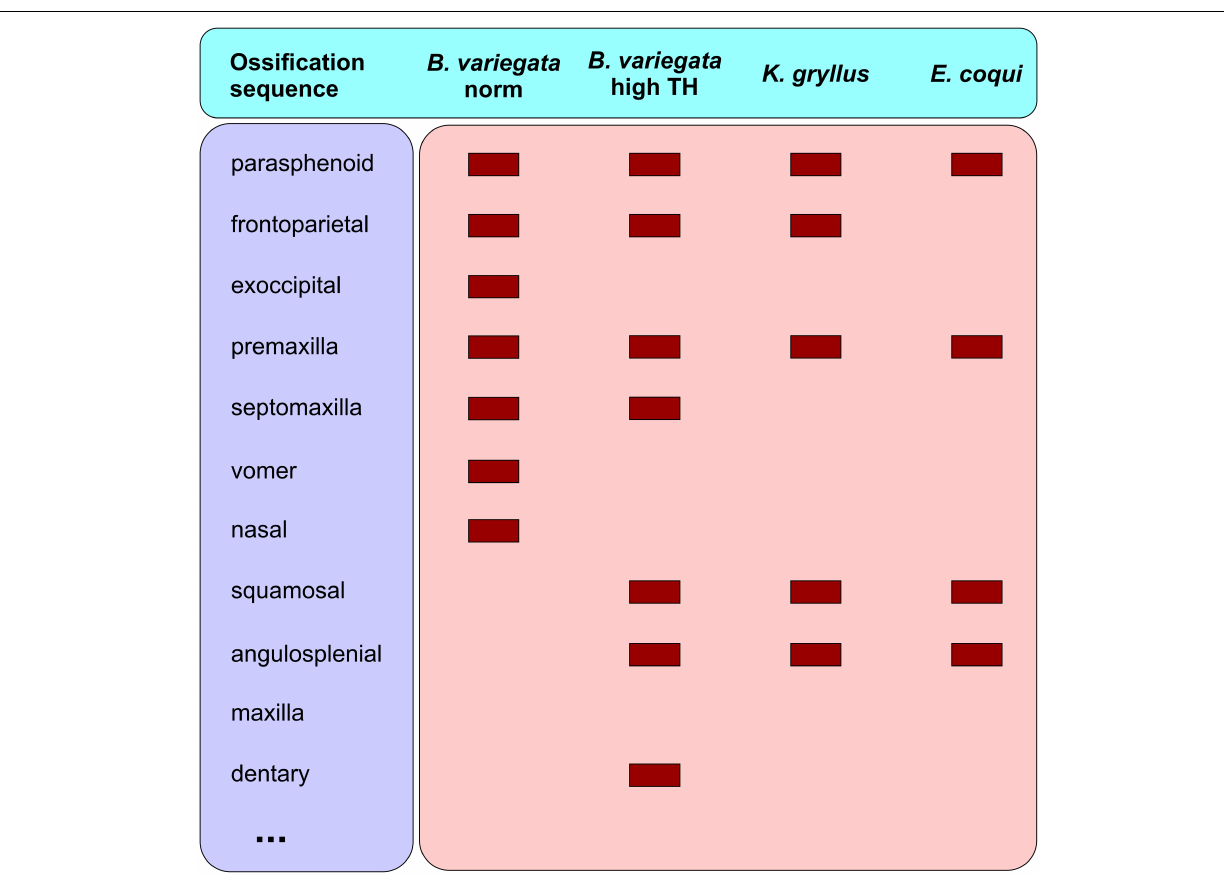
are lost in paedomorphic frogs (Davies, 1989; Yeh, 2002).